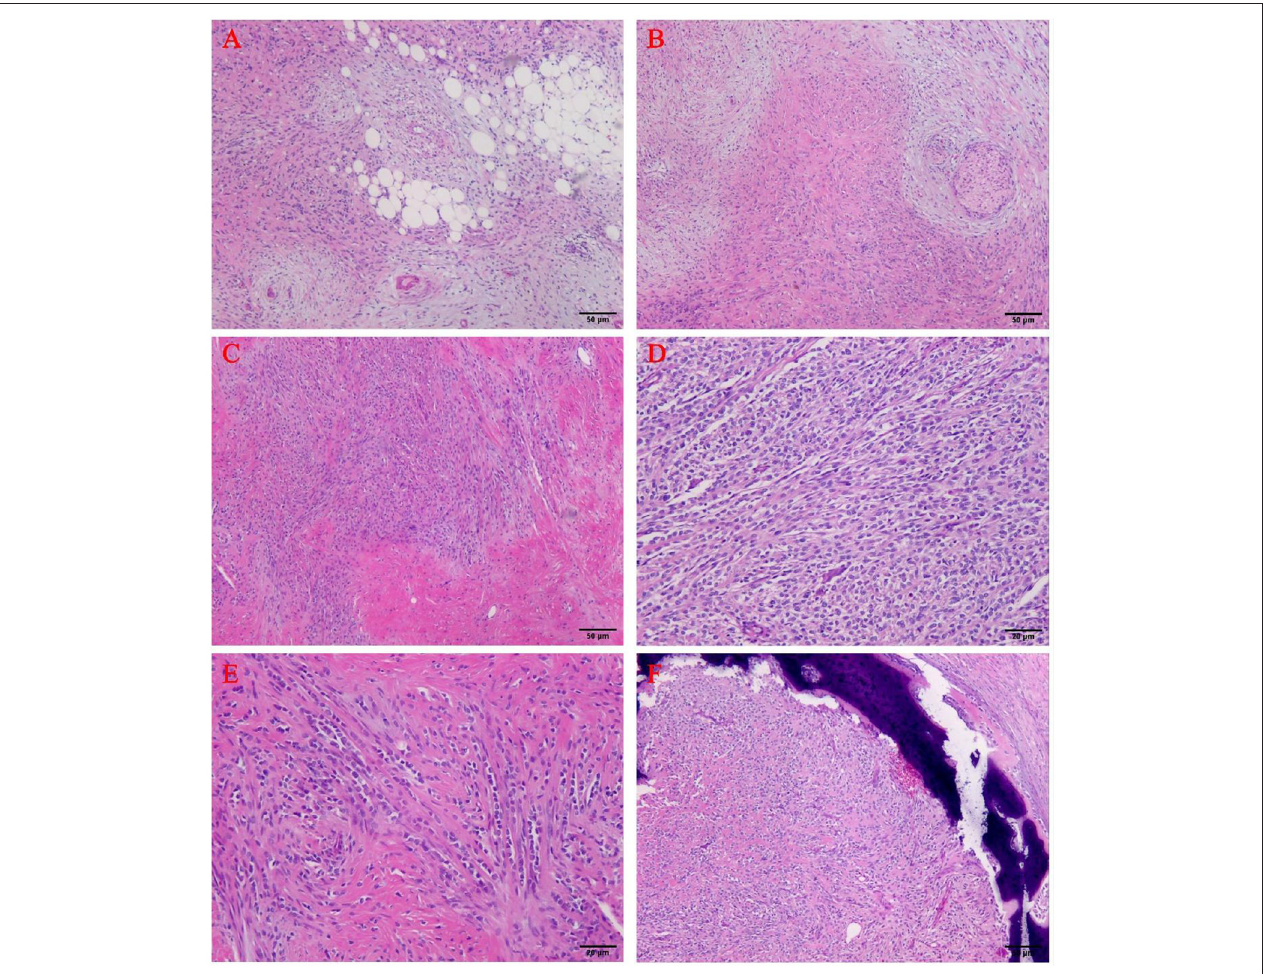
FIGURE 3 | H&E staining results. (A–C) The tumor-rich areas, collagen fiber sclerosis areas and mucus areas were found to be staggered (40X). (D,E) The tumor cells were embedded in the fibrous matrix, and small and medium-sized epithelioid cells were arranged in cords and nests (100X). (F) The tumor invaded the bone of the spine